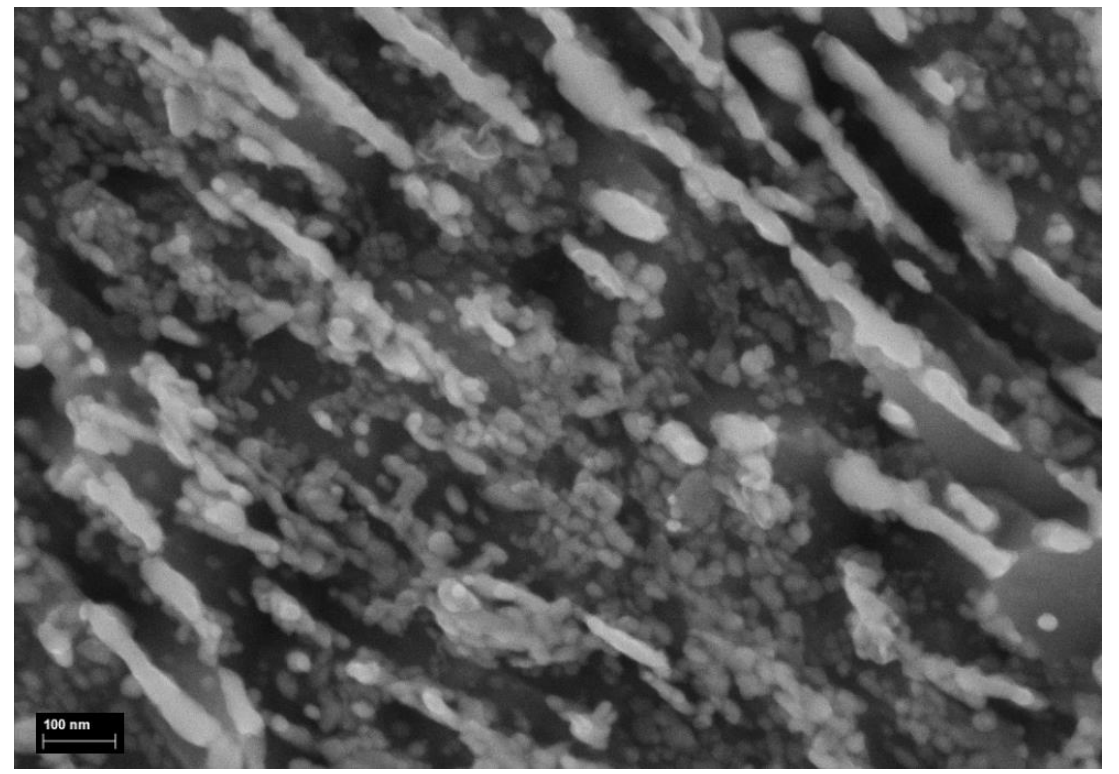
Figure 4. Electric-effect-induced formation of nanostructured FeC 3 grains from the originally thin plate in cold-drawn pearlitic wire.